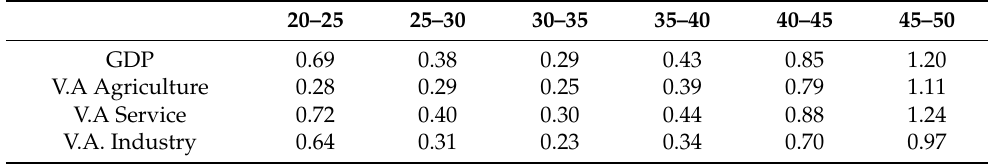
Table 2. Evolution of Italian main macroeconomics drivers, average annual rate,